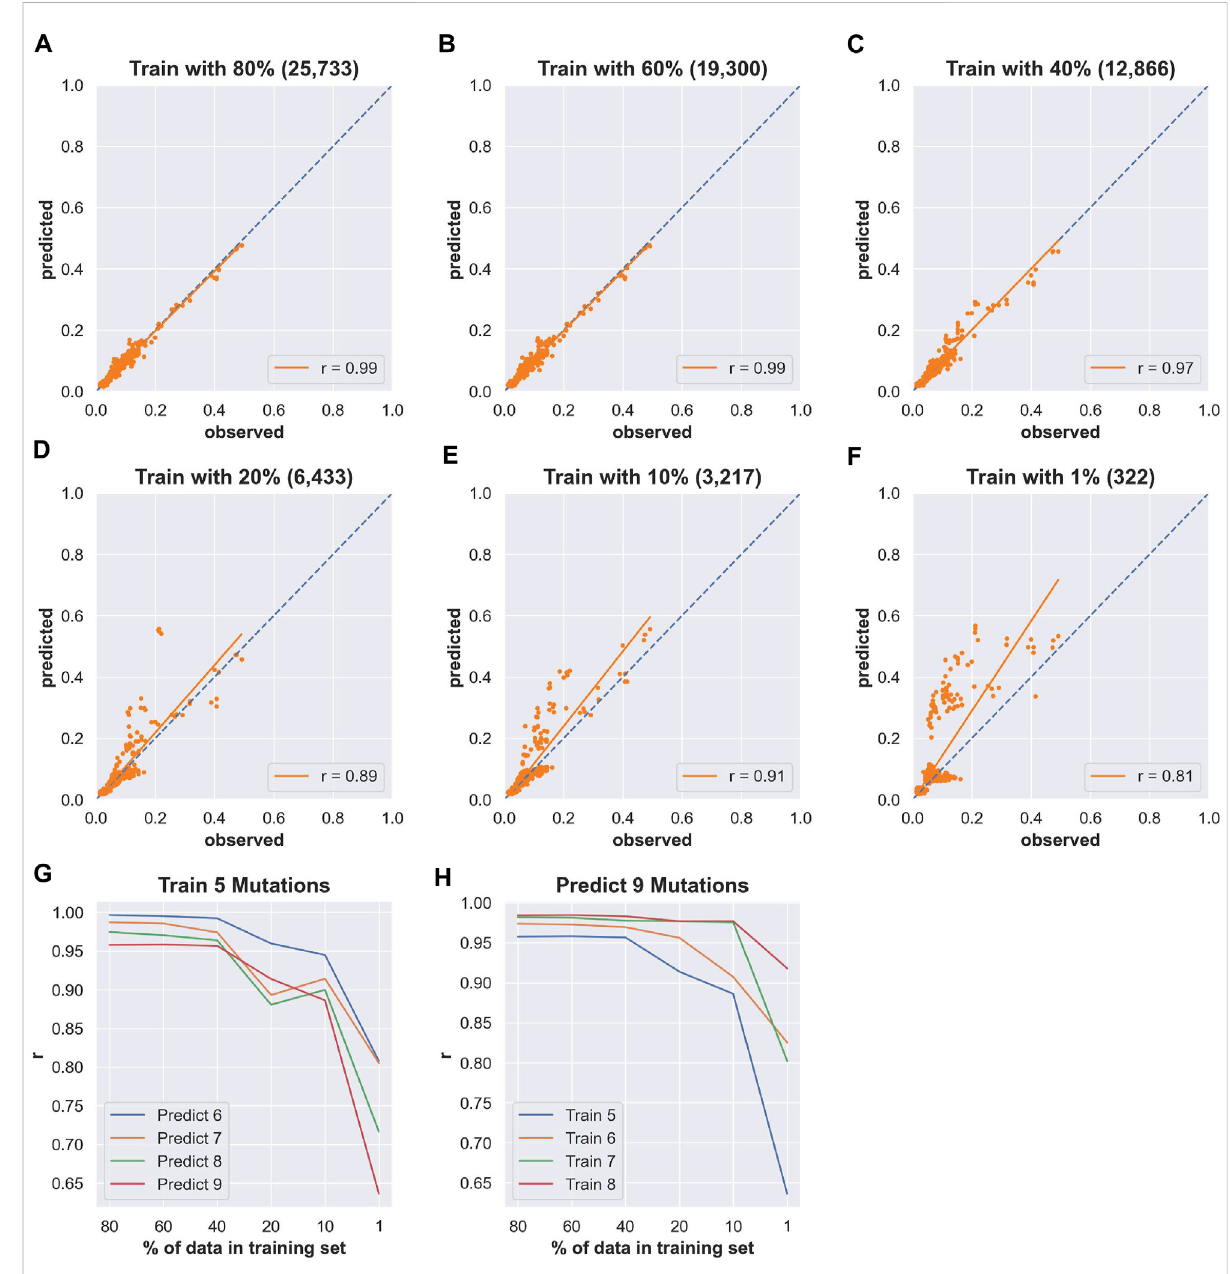
FIGURE 4 Effects of reducing the number of sequences in the training data. (A – F) Scatter plots of Predicted (fraction cleaved from the models) and Observed (fraction cleaved from experiments) for models trained with decreasing amounts of sequences with fi ve or fewer mutations using the random forest approach and predicting the fraction cleaved of sequences with seven mutations. The percent of the total sequence used in the training data is indicated in the title of each plot, and the number of unique sequences in the training data is reported in parentheses. Pearson correlation coef fi cients r are indicated as insets. (G) The correlation between predicted and observed for a model trained with decreasing amounts data from sequences with fi ve or fewer mutations ( “ Train 5 ” ) and predicting the activity of sequences with increasing numbers of mutations (Predict 6 – 9). (H) Predicting the activity of sequences with 9 mutations ( “ Predict 9 Mutations ” ) with models trained on different reduced data